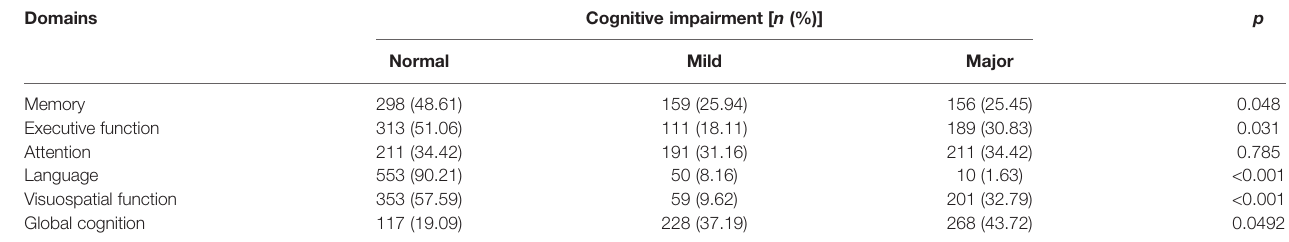
TABLE 2 | Different proportions of the cognitive impairment in different cognitive domains. Domains